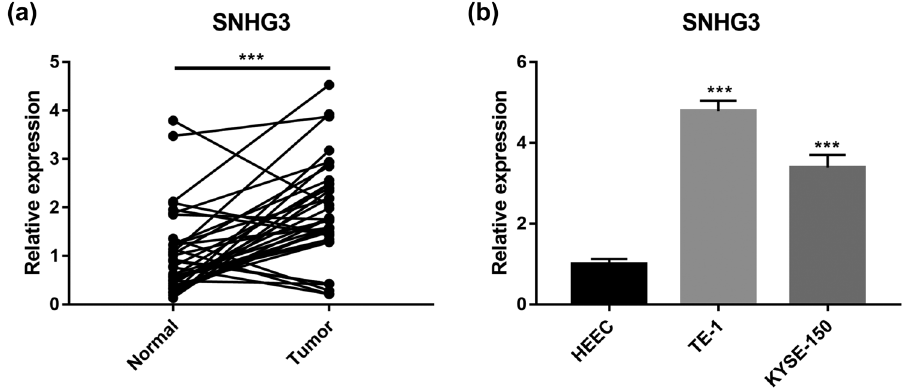
Figure 1: lncRNA SNHG3 was upregulated in ESCC tissues and cells. ( a ) qRT - PCR assay was used to detect the expression of SNHG3 in ESCC tissues and normal tissues. ( b ) qRT - PCR assay was performed to examine the expression of SNHG3 in ESCC cells and corresponding normal cells. *** P <